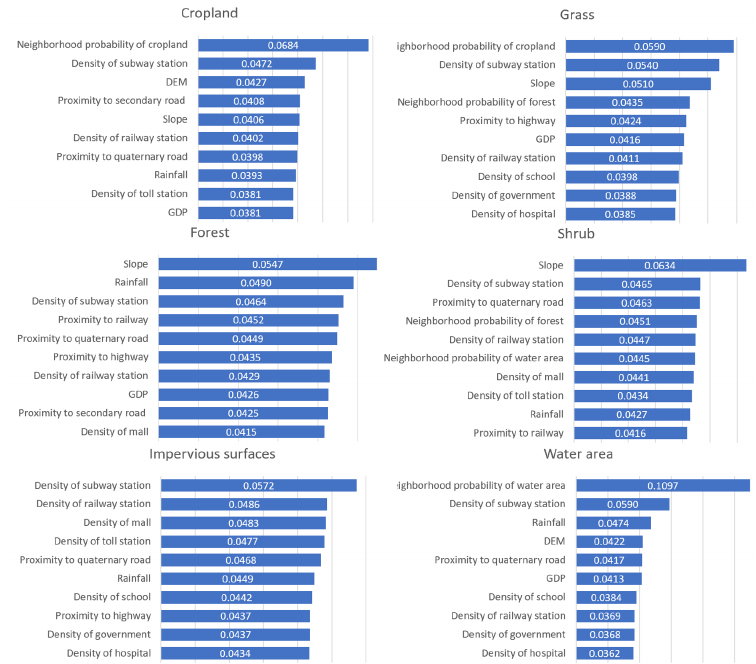
Figure 9. Importance of driving